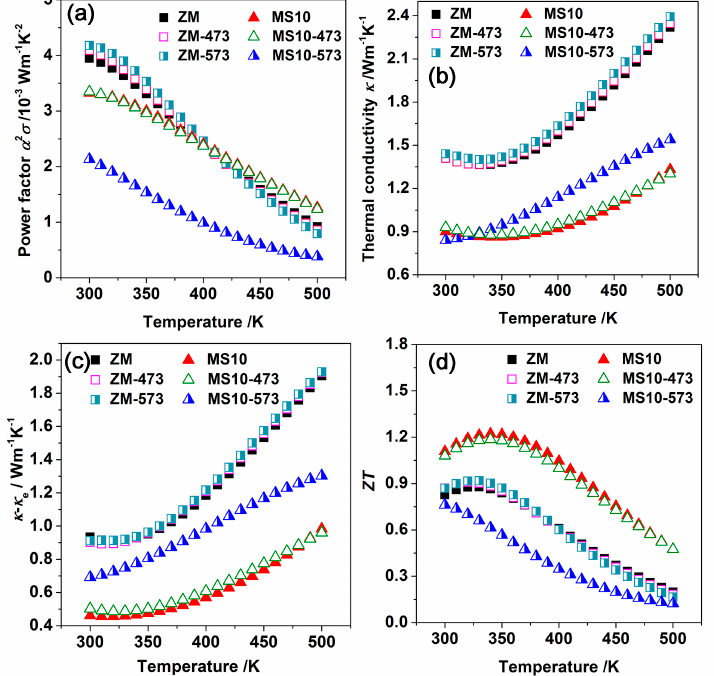
Figure 4. Temperature dependence of ( a ) power factor; ( b ) thermal conductivity; ( c ) lattice thermal conductivity and ( d ) ZT values for ZM and MS10 samples before and after annealing.